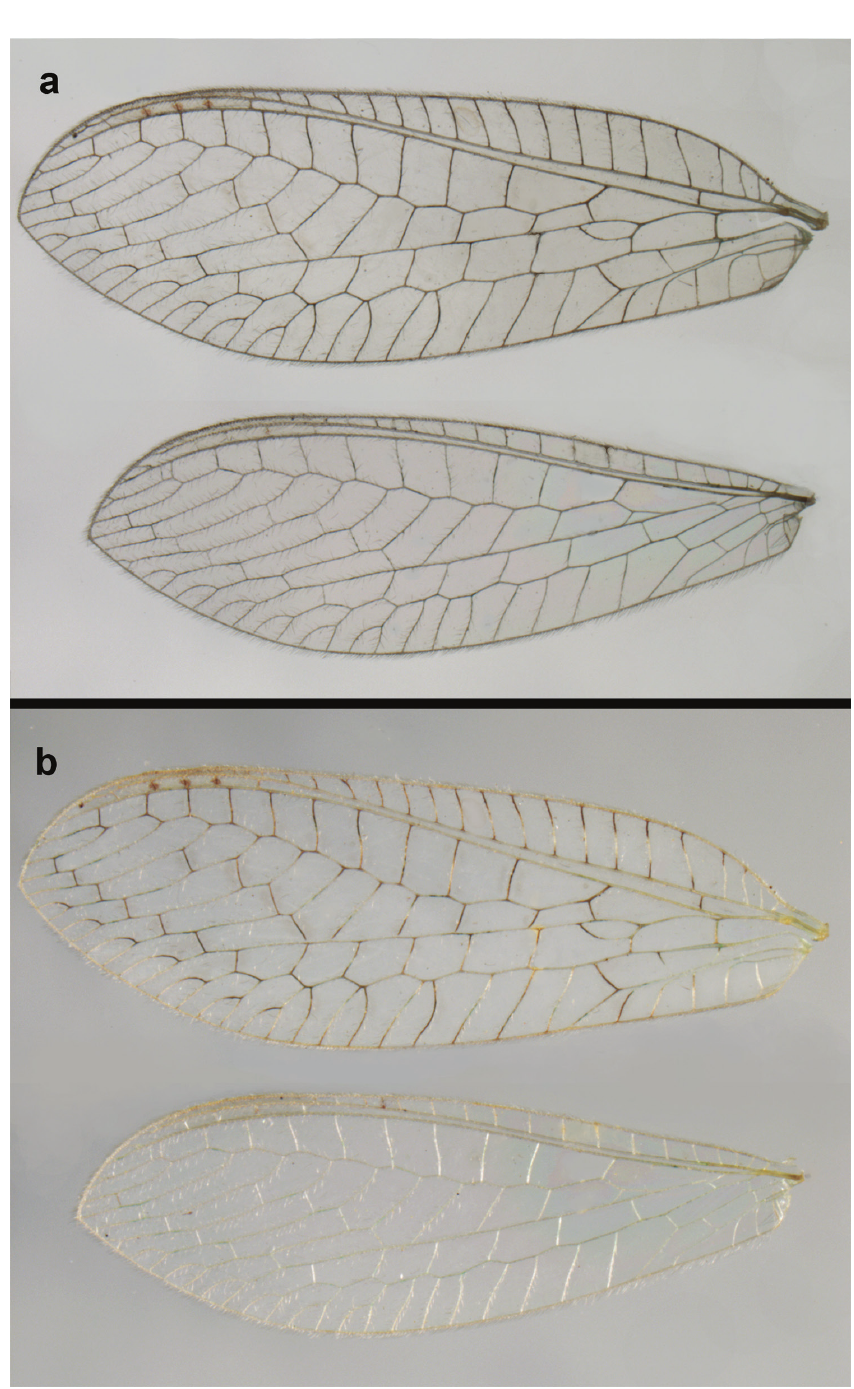
Figure 62. Ungla mexicana Tauber, sp. n. Wings, ( a ) venation emphasized ( b ) coloration of veins em- phasized (Mexico, Chiapas, holotype, female, CAS)